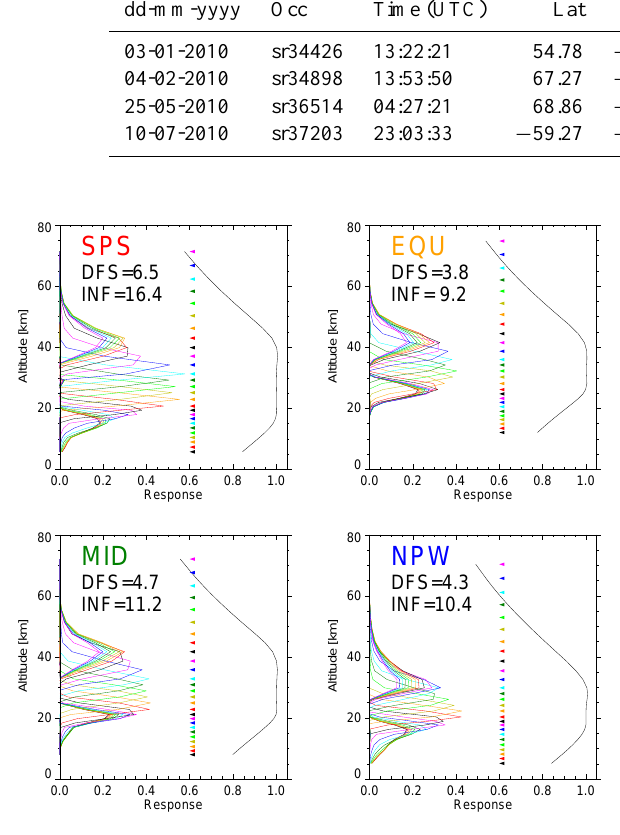
Figure 5. Averaging kernels (i.e. rows of the averaging kernel ma- trix) of the retrievals shown in Fig. 4. The retrieval altitude of each averaging kernel is indicated by the arrow with matching colour. The solid black line represents the summation of all the elements of each averaging kernel. The figures in each panel refer to “degrees of freedom for signal” (DFS), i.e. the number of independent pieces of information in each profile of 27 levels, which is the trace of the averaging kernel matrix and (INF) Shannon information content (in bits), which includes information from the off-diagonal elements. Of the four regions considered in the plot, the MIPAS COF 2 re- trieval is most sensitive in southern polar summer with the combi- nation of high concentrations and high stratospheric temperatures.